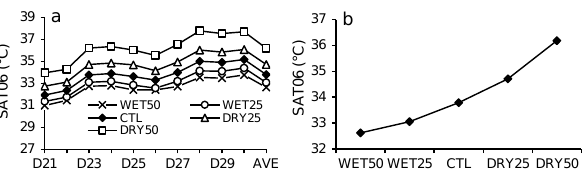
Figure 4. The average SAT06 values for area D3 in the simulations. (a) The values as changed with the individual simulations with an average (AVE) for each group of simulations. (b) The 10-day means as changed with the five groups of